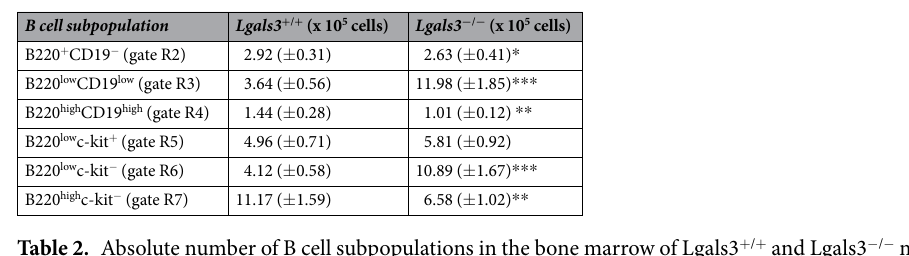
Table 2. Absolute number of B cell subpopulations in the bone marrow of Lgals3 + / + and Lgals3 − / − mice. Data are plotted as means obtained from three independent experiments. ( * ) indicates p ≤ 0.05, ( ** ) indicates p ≤ 0.01 and ( *** ) indicates p <